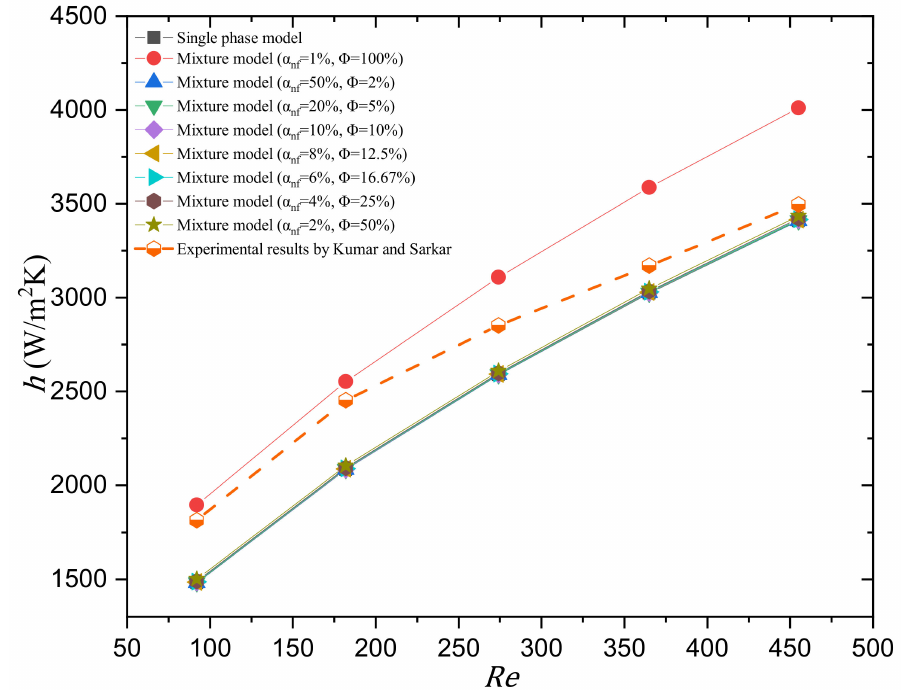
Figure 8. Average heat transfer coefficient of the minchannel heat sink from using the single-phase approach and the two-phase mixture model at 92 ≤ Re ≤